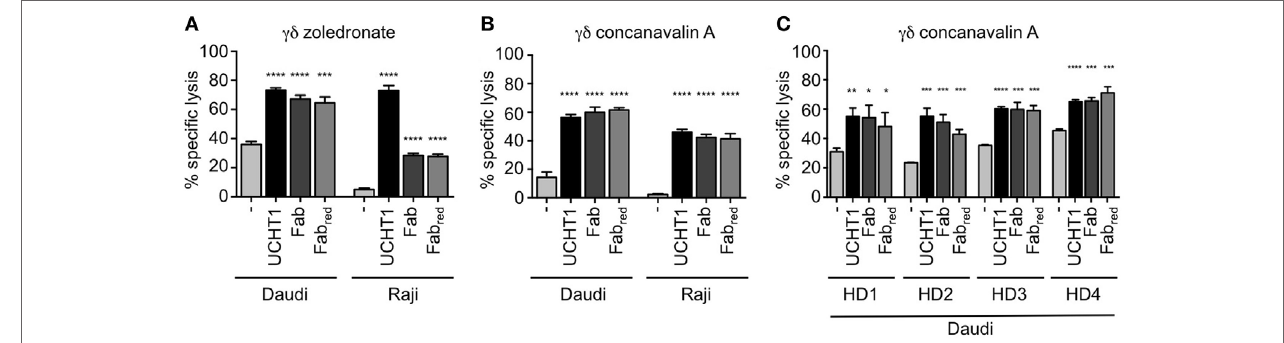
FigUre 4 | Fab and Fab red fragments enhanced tumor killing by γδ T cells. 51 Cr-labeled Daudi and Raji cells were incubated with zoledronate (a) or concanavalin A (B) expanded γδ T cells in triplicates without (−) or with 5 µg/ml UCHT1, 3.33 µg/ml Fab, or 3.33 µg/ml Fab red (these concentrations were chosen to obtain equimolar amounts of the different reagents). The effector to target ratio was 12.5:1. After 5 h of co-culture, the amount of released 51 Cr was measured in the supernatant by γ -ray spectroscopy ( n = 3). (c) Concanavalin A expanded γδ T cells from four different donors (HD1, 2, 3, and 4) were used in a chromium-release assay using Daudi cells as target as in (a) ( n = 1). Data represent mean ± SD of triplicate wells. Significance was determined by unpaired t -test, two-tailed between untreated γδ T cells and UCHT1, Fab or Fab red -treated samples.